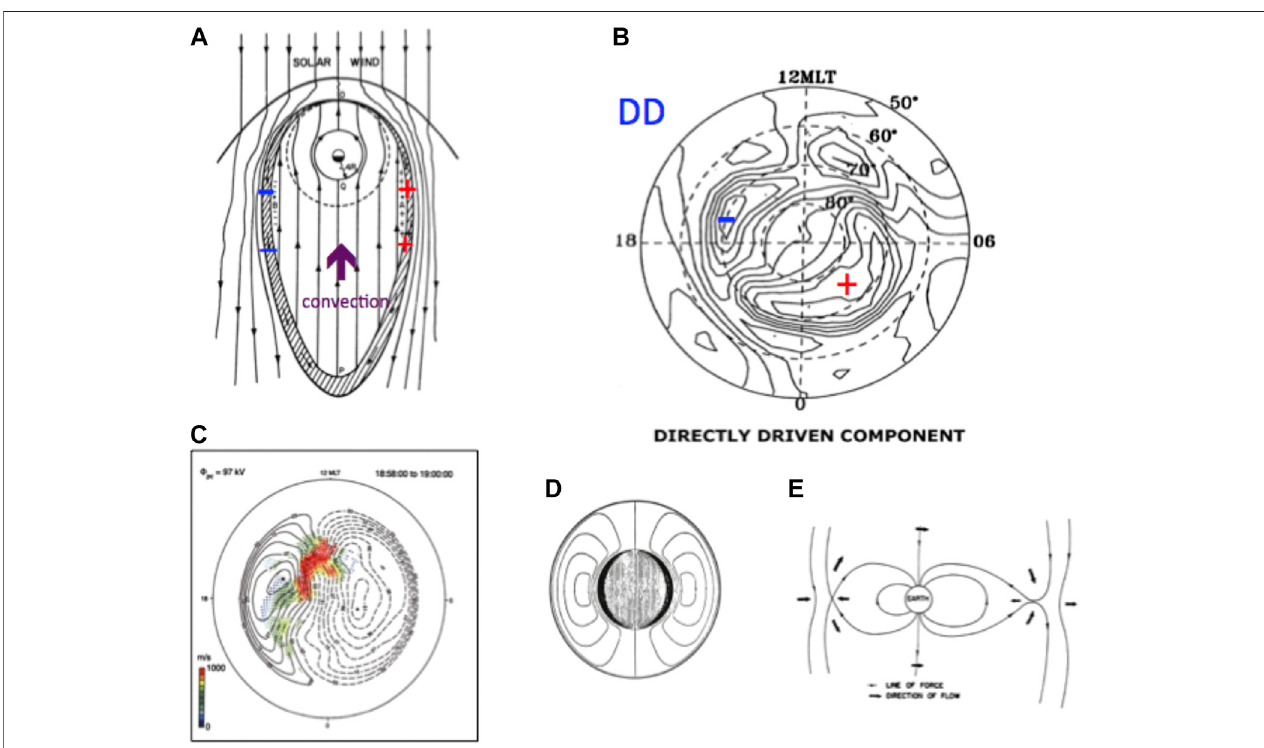
FIGURE 11 | (A) The convection pattern of plasmas in the equatorial plane, suggested by Axford and Hines (1961) on the basis of Chapman ’ s SD current. (B) The ionosphericconvectionpattern(thesameastheDDcurrent,thecurrentlineisthesameastheconvectionline)basedontheanalysisofthesixmeridianchainsofstation. (C) An example of the superDarn observation of the ionospheric convection (Bristow and Jensen, 2007). (D) Chapman ’ s SD current. (E) Dungey of convection model based on the SD current (Dungey, 1961).